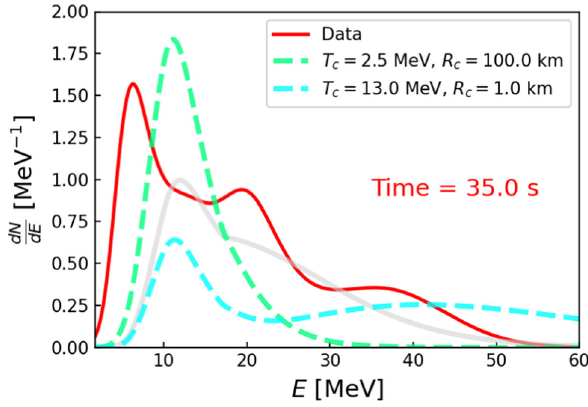
Fig. 4 To visualize the effect of spectral distortion impact on events rate, we used two sets of parameters for T a and M a (in green and in cyan) that are excluded at 90% C.L. according to our analysis. The green curve produces a distortion for low energy events, while the cyan produces a distortion that favour high-energy events. Also on light grey we present the best-fit point of our analyses, shown in Fig. 2 (see the animation here: https://github. com/santosmv/Animations-visualizing-SN1987A-data-analysis/blob/